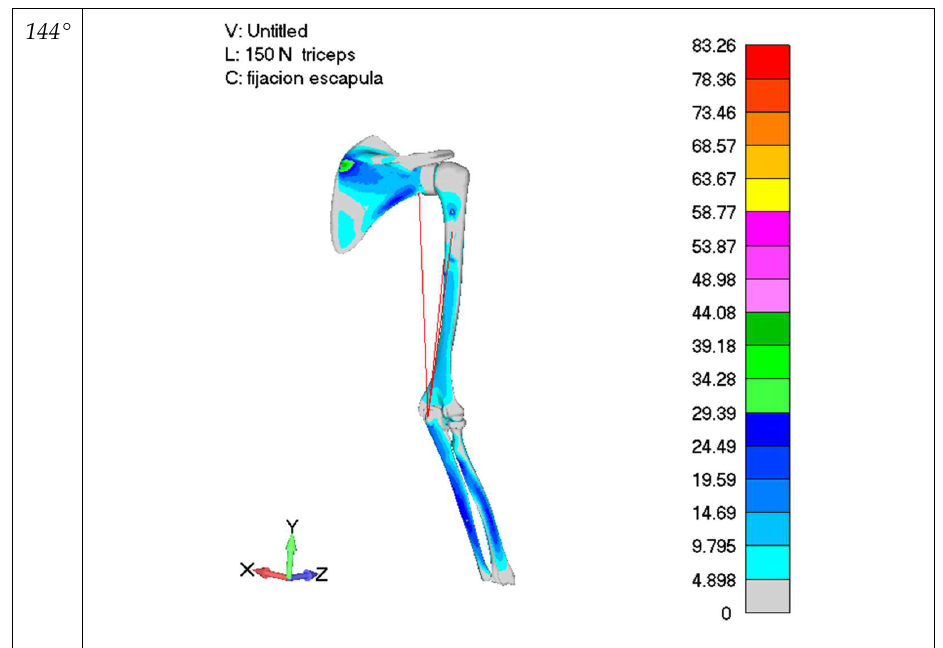
Figure A2. Different Elbow Angle Configuration: Bone Von Mises Stress Distribution Triceps Loading Case (150 N on wrist).